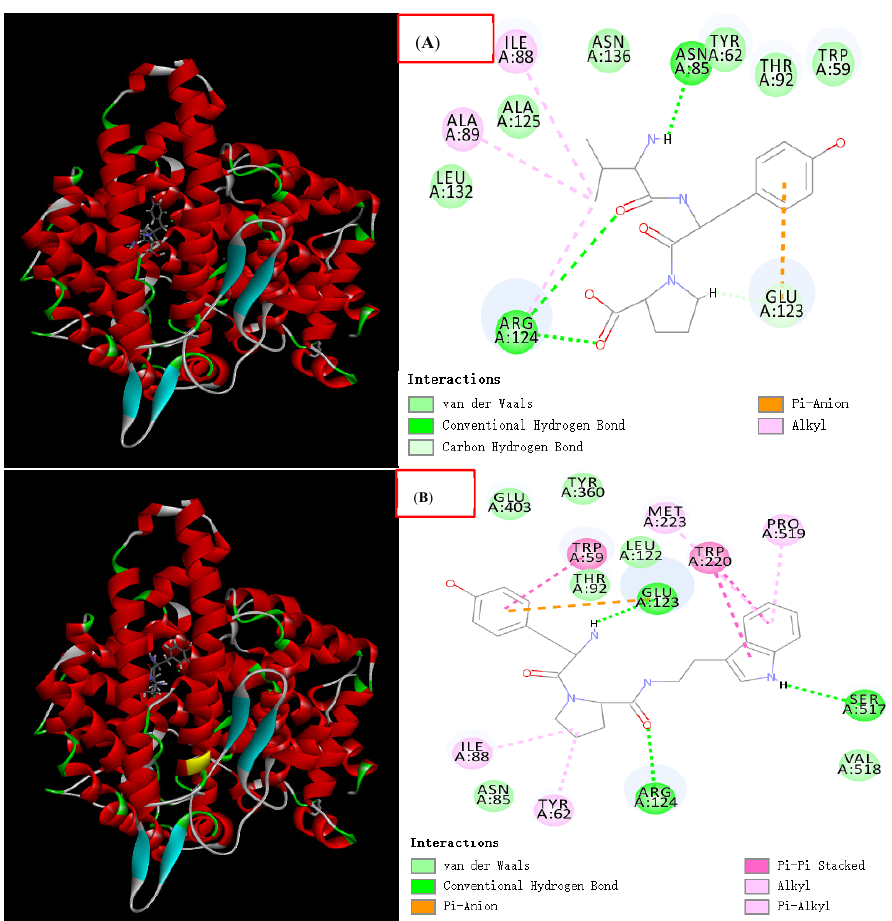
Figure 15. Molecular docking results for two shared tripeptides, VYP(Val-Tyr-Pro) and YPW(Tyr-Pro- Trp). ( A ) represents the binding mechanism between VYP and the receptor ACE. ( B ) represents the binding mechanism between YPW and the receptor ACE. VYP, respectively, forms one hydrogen bond with Glu123, Arg124, Arg124 and Asn85, and forms a conjugate bond with the six-membered ring of tyrosine, and the mo- lecular docking score is 108 points. YPW, respectively, forms one hydrogen bond with Arg124, Ser517, and Glu123 and, respectively, forms a conjugated bond with the six-mem- bered ring of tyrosine, either of the five-membered ring and six-membered ring of trypto- phan, and the five-membered ring of proline. The molecular docking score is 138 points. It shows that the above two tripeptides have certain ACE inhibitory activity. 3.8. Stability Verification of ACE Inhibitory Peptides 3.8.1. pH Stability of ACE Inhibitory Peptides The inhibitory activity of ACE was less affected by pH, and its activity remained above 90% in different pH solutions within the range of 2 to 12 (Figure 16), indicating that ACE inhibitory peptides had good tolerance to acid and basic conditions.